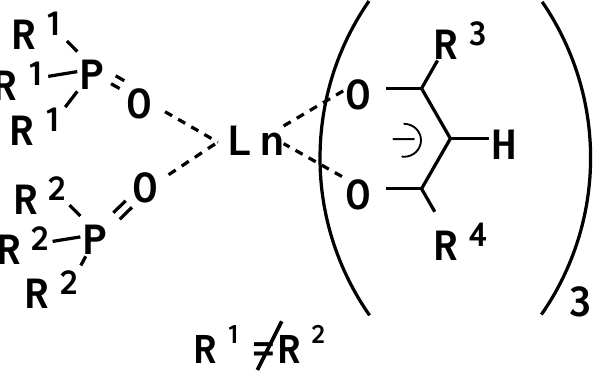
two different phosphine oxides.